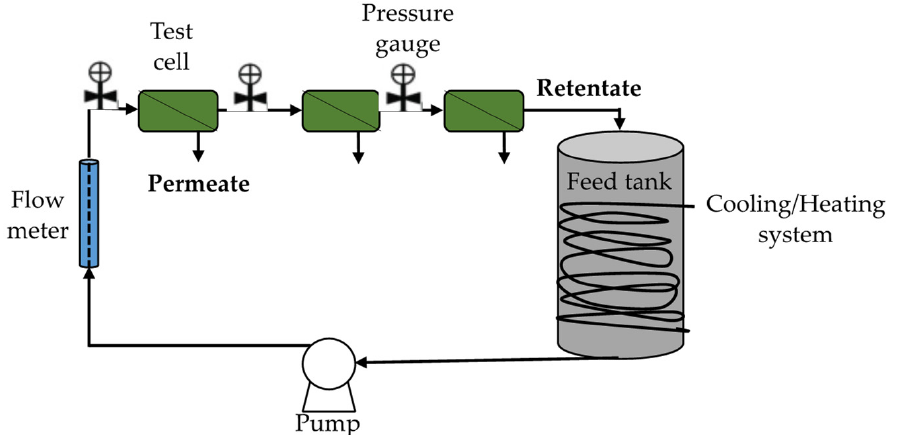
Figure 7. Example of scheme of a cross-flow desalination system for nanomembranes. Based on Safarpour et al. [83].